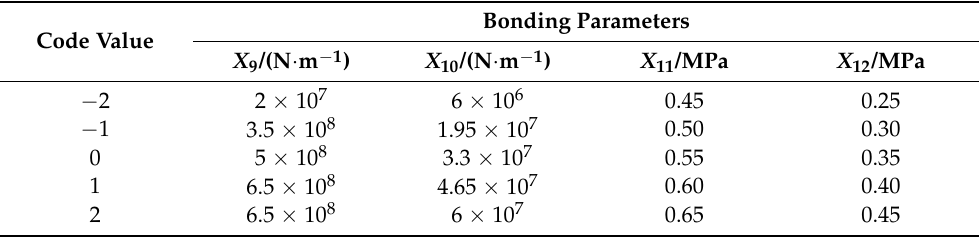
Table 9. Parameter codes of the epidermal and inner flesh bonding model.